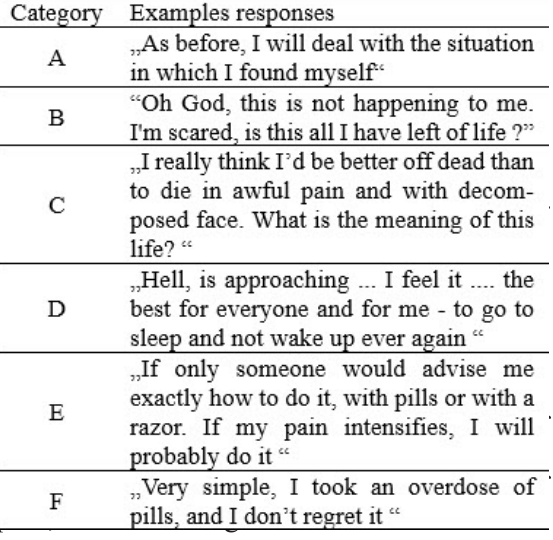
Table 2. Examples responses at inter-